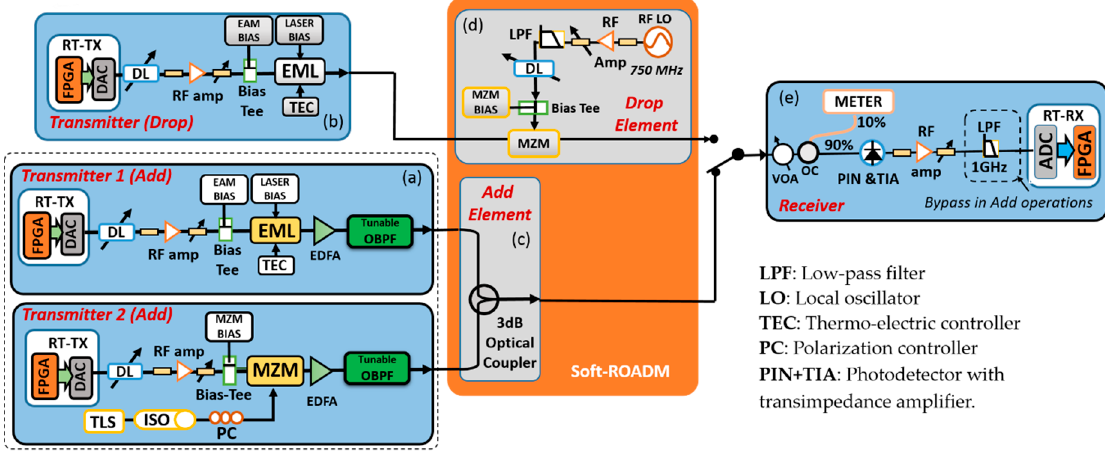
Figure 8. Soft-ROADM add and drop operations experimental system setup. ( a ) Transmitter system for add operations; ( b ) transmitter system for drop operation; ( c ) add element; ( d ) drop element; and ( e ) receiver system.